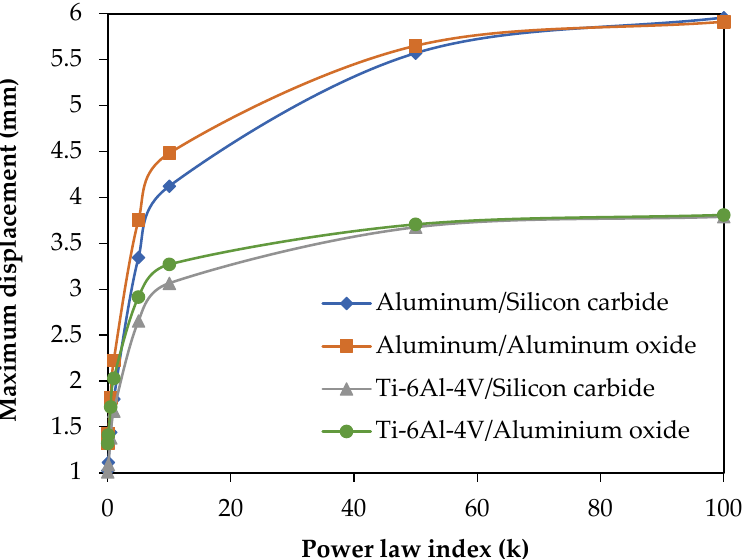
Figure 3. Variation of maximum displacement of the re-entry vehicle nose shell structures for varying power law indices.